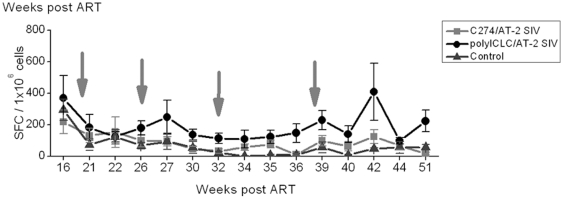
SIV-specific T cell responses were similar across groups.The average SIV-specific (to AT-2 SIV) IFNγ ELIPSOT responses during the vaccination are illustrated (±SEM). SIV specific responses were determined by subtracting the appropriate MV response.